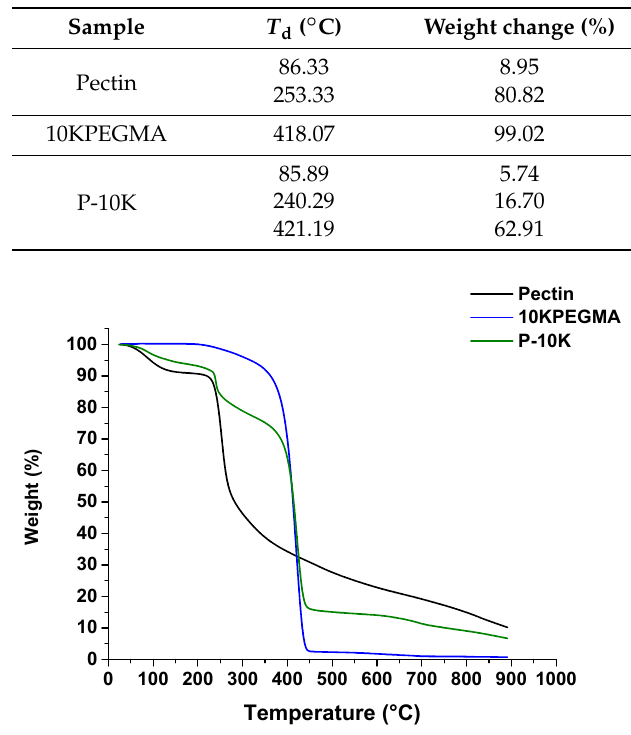
Figure 4. TGA curves of the precursors (pectin and 10KPEGMA) and copolymer P-10K.